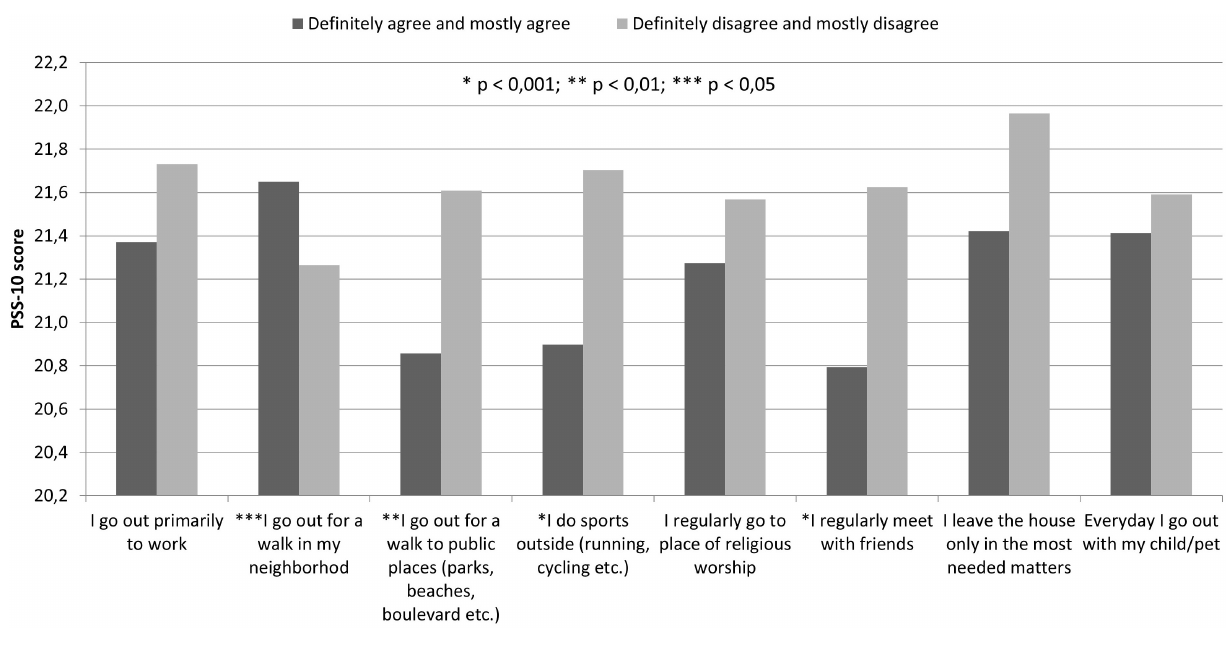
FIGURE 2 | Perceived stress and restriction